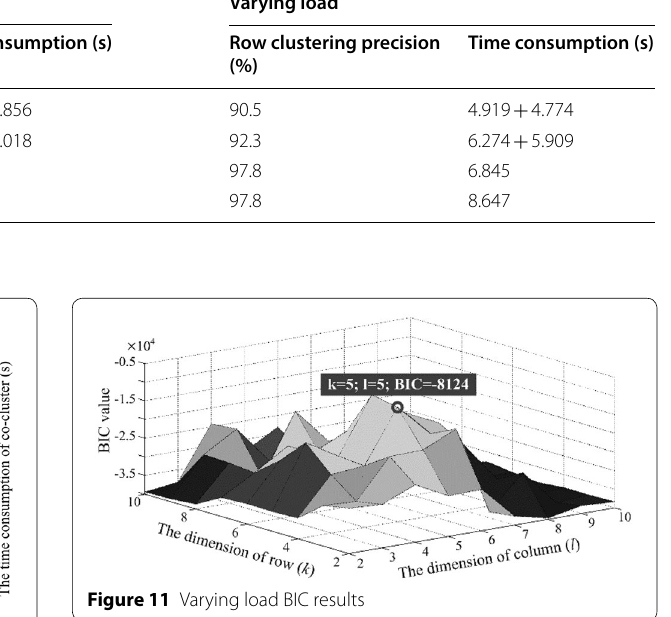
Table 8 Performance comparison of different GFD models Model